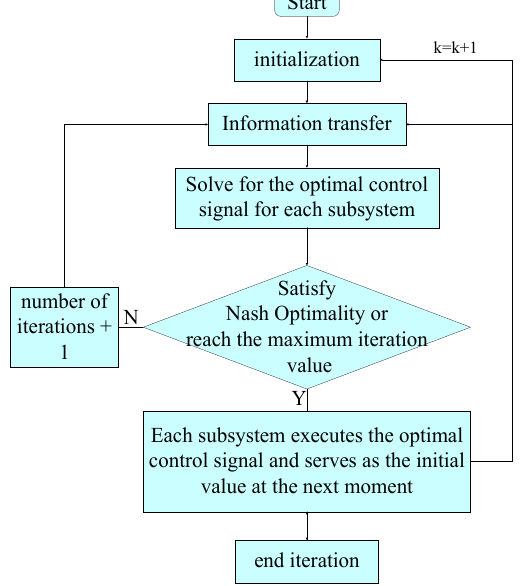
Figure 5. Flow chart of distributed predictive control